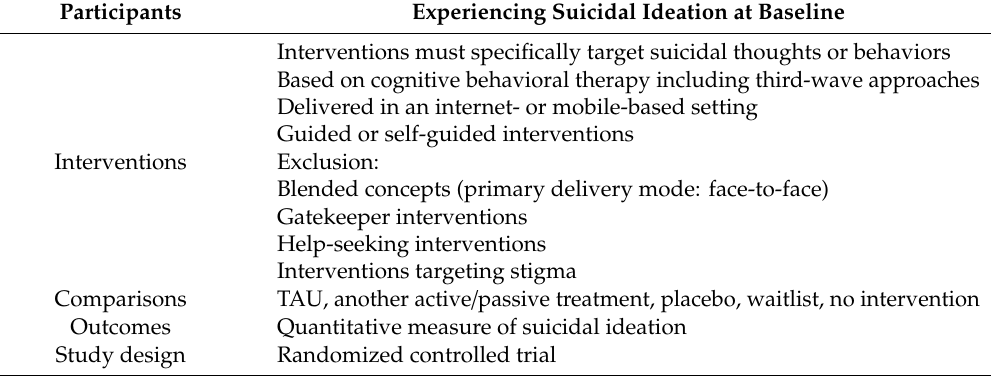
Table 1. Eligibility criteria